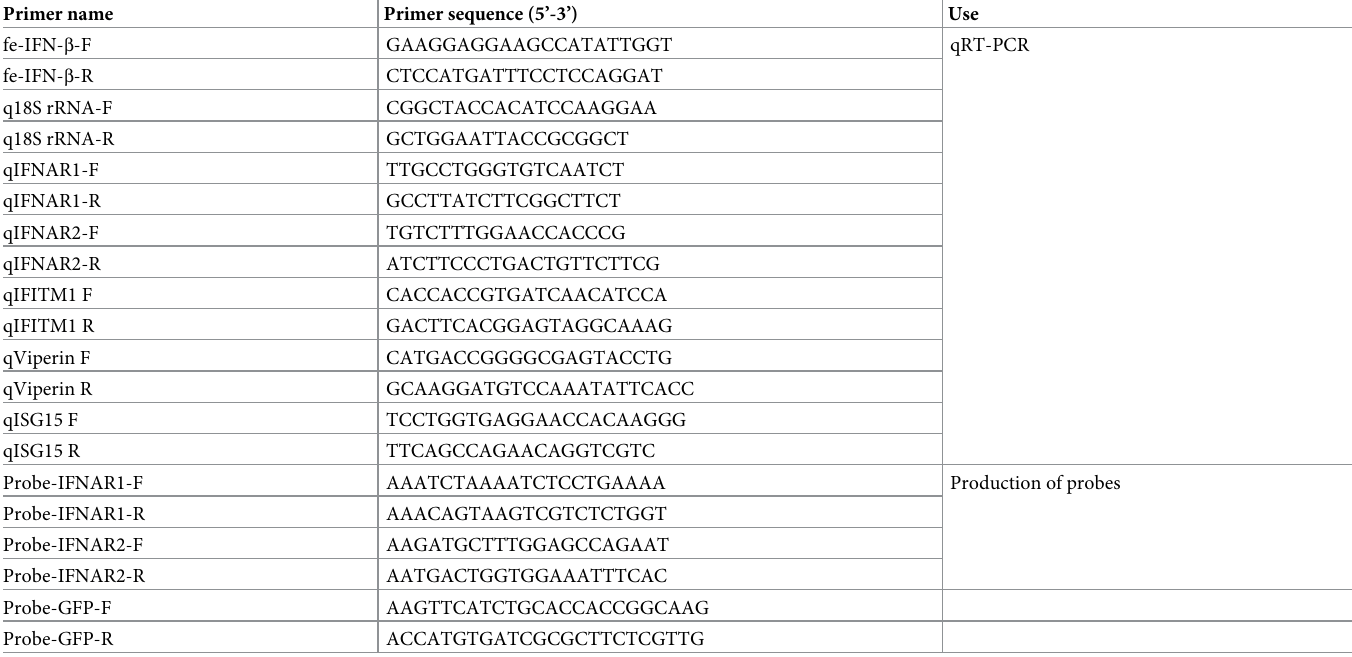
Table 1. Primers for qRT-PCR and production of